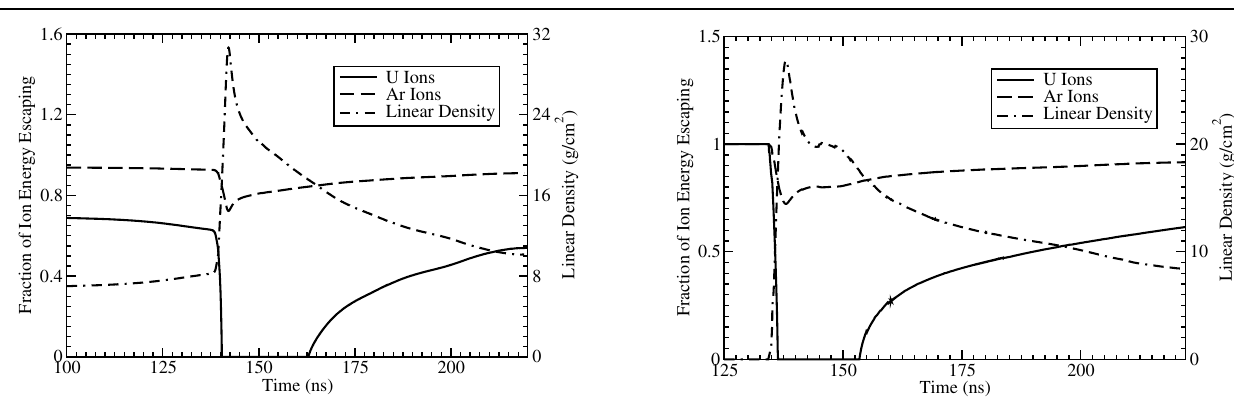
FIG. 28. Same as in Fig. 26, but using the beam-target geometry shown in Fig.